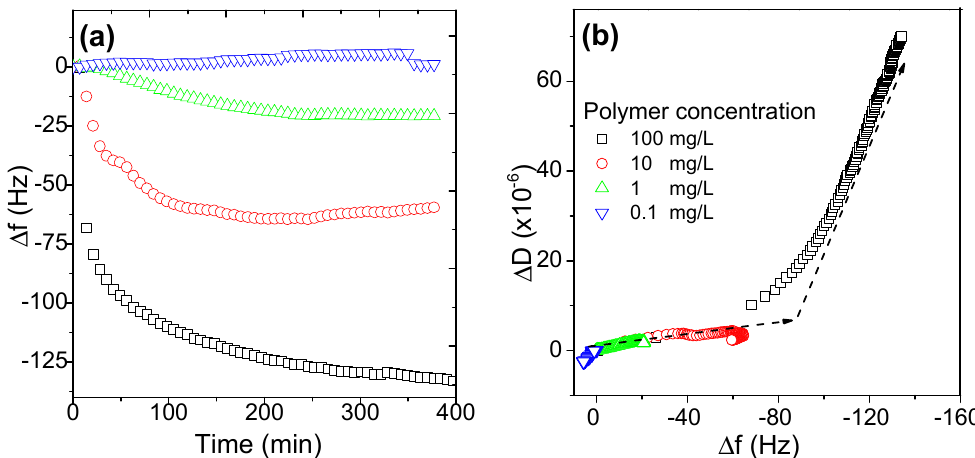
Figure 3. Effects of polymer concentration on the adsorption amount ( a ) and on the conformation ( b ) of the AmPAM adlayers on silica surface. The tested AmPAM sample with MW of 336 k, concentration ranging from 0.1 to 100 mg/L, and the ionic strength was controlled at 0.02 M.